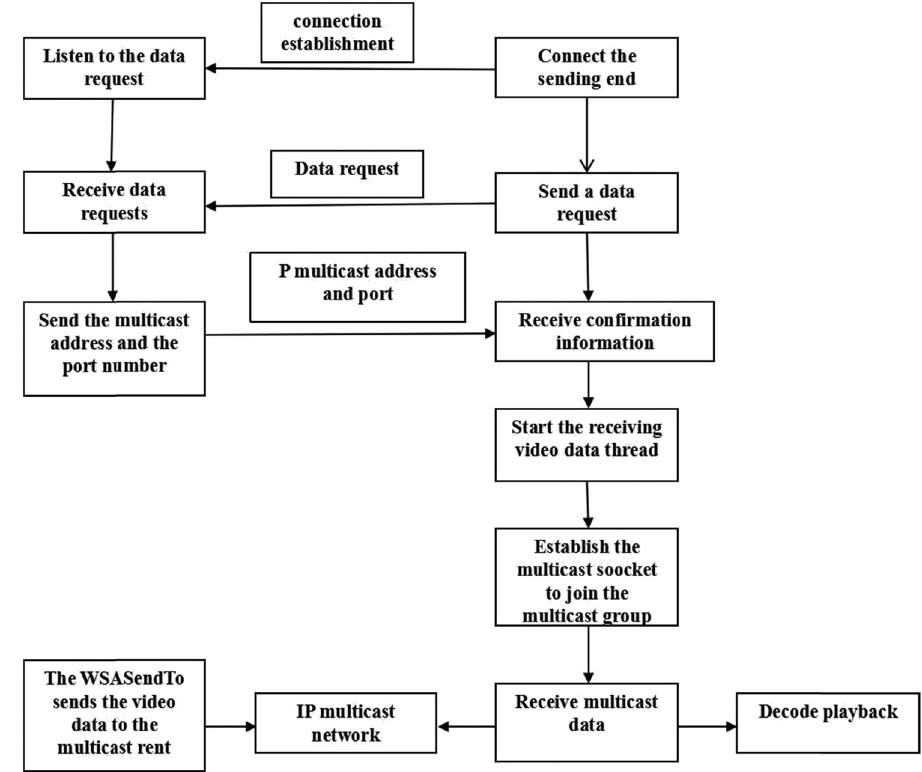
Figure 3: The process of receiving and playing video.